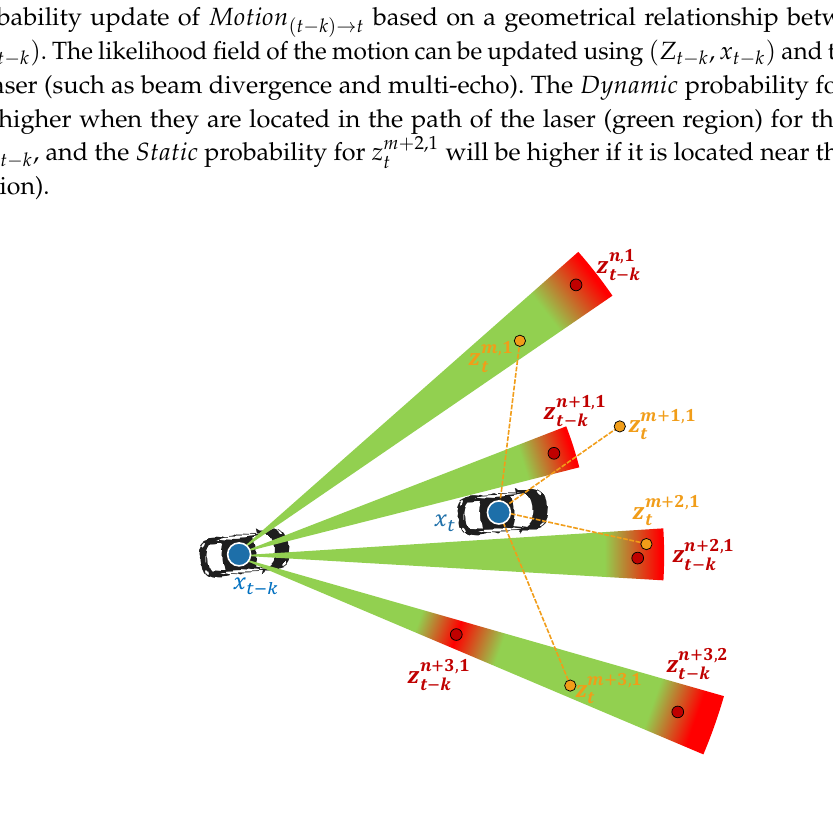
Figure 2. Probability update of Motion ( t − k ) → t . The motion probability of the point cloud Z t can be updated based on the geometric relationship for the previous point cloud Z t − k